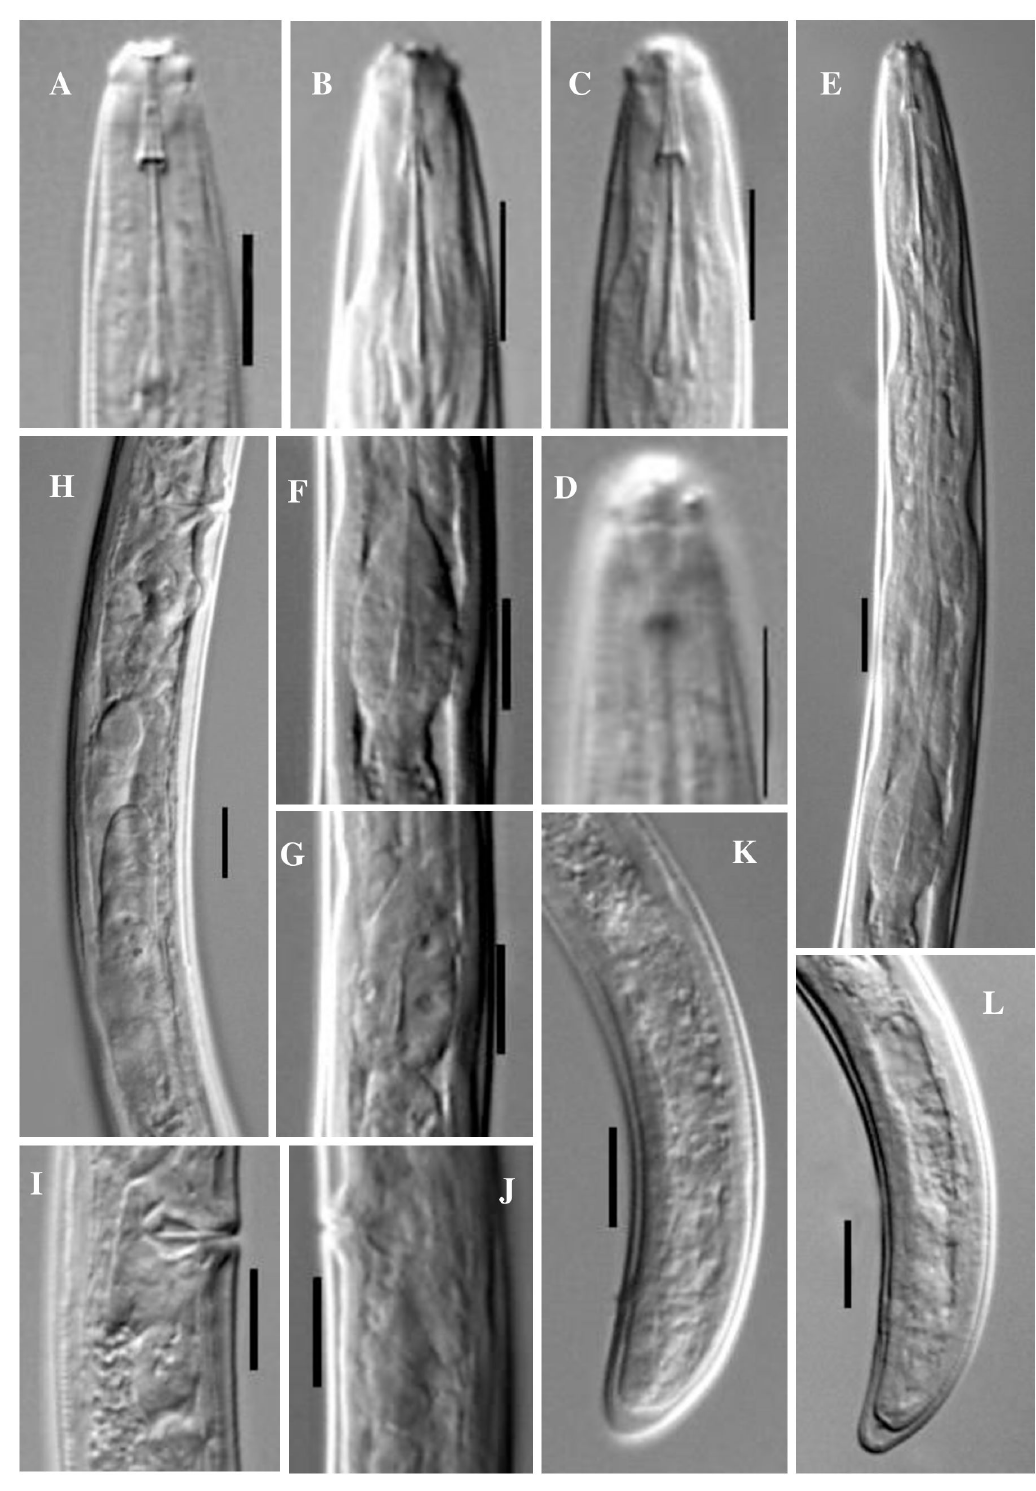
Fig. 3. Basirotyleptus nindei Siddiqi, 1970, ♀ (AMU/ZD/NC/ Basirotyleptus nindei /1–4) (LM photographs). A–C . Anterior region. D . Anterior region showing amphid. E . Pharyngeal region. F–G . Pharyngeal bulb. H . Genital system. I–J . Vulval region. K–L . Posterior region. Scale bars = 10